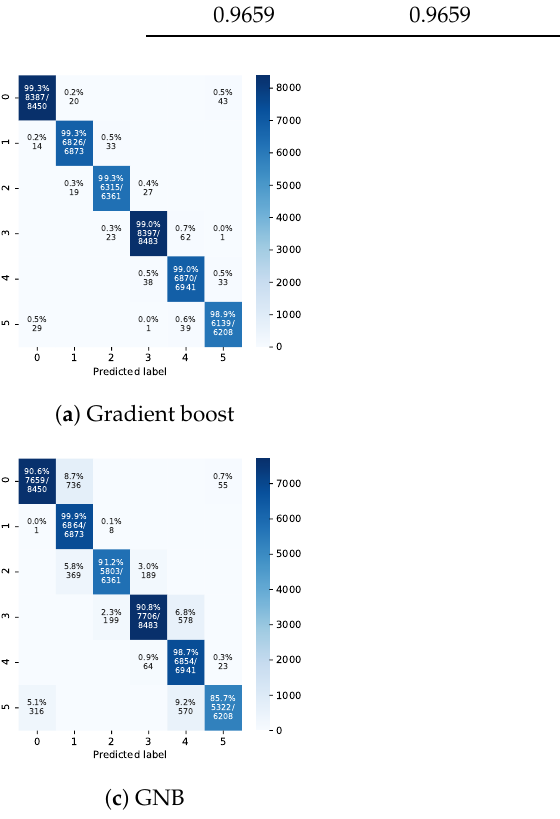
Figure 6. Confusion matrices for